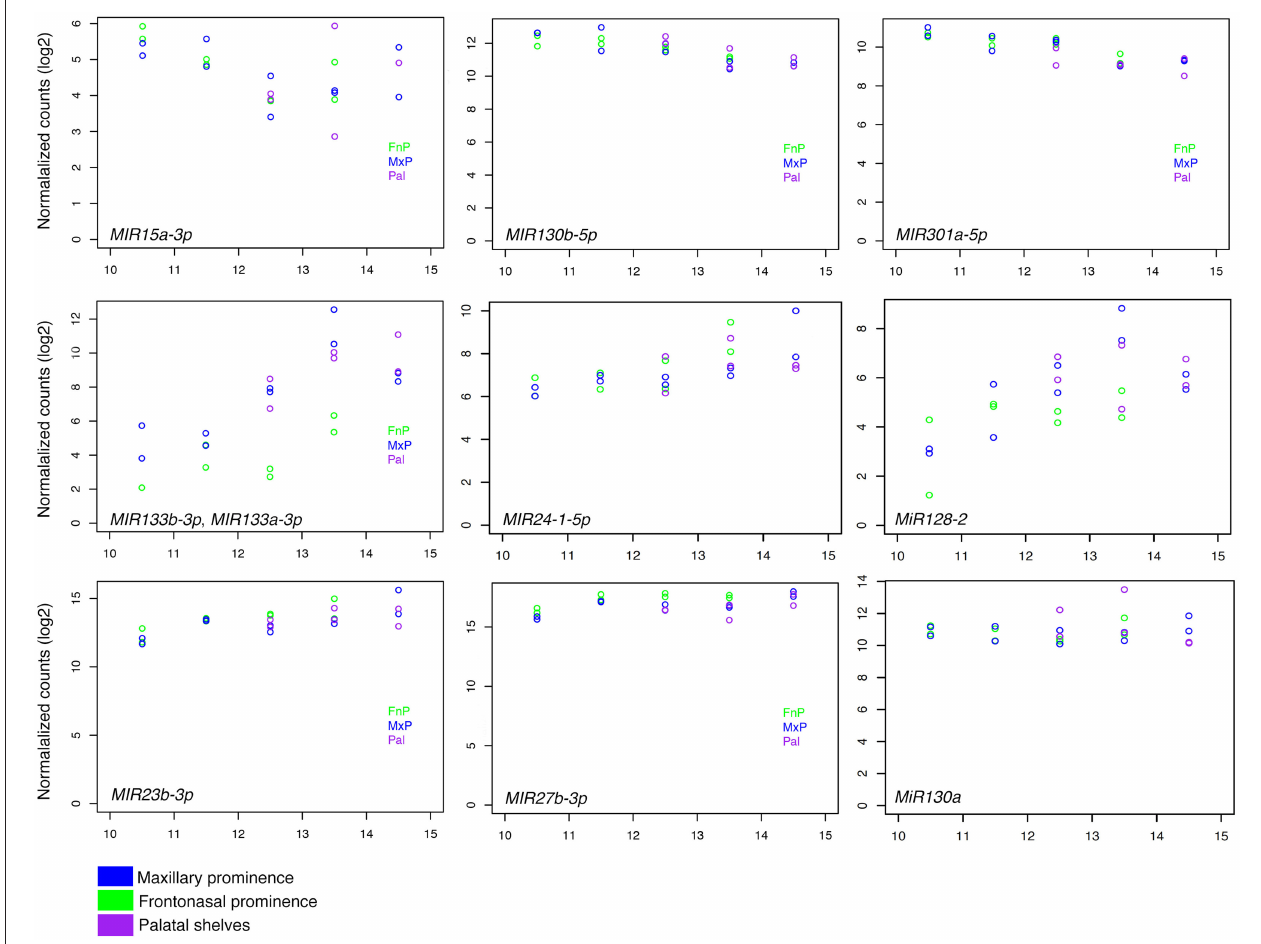
FIGURE 2 | RNAseq values for expression of selected miRNAs. Normalized counts for selected miRNAs from each prominence (see inset) as compared to embryonic age (E10–15). Each row represents a different pattern of expression over time. (Top) Mir15a , Mir130b , and Mir301a showed a downward trend of expression over time. (Middle) Expression of Mir133b , Mir24.1, and Mir1282 increased over time. (Bottom) Mir23b , Mir27b , and Mir130a were expressed consistently over time. Blue, Maxillary prominence; Green, Frontonasal prominence; and Purple,